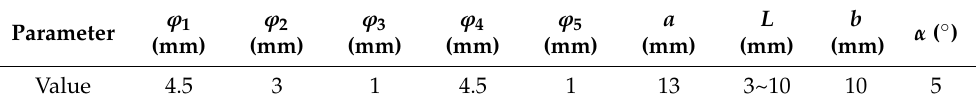
Figure 6. Setup of brushing micro-manipulator: ( a ) Horizontal brushing micro-manipulator. ( b ) Vertical brushing micro-manipulator. Table 2. Geometric dimensions of brushing micro-manipulator. Table 2. Geometric dimensions of brushing